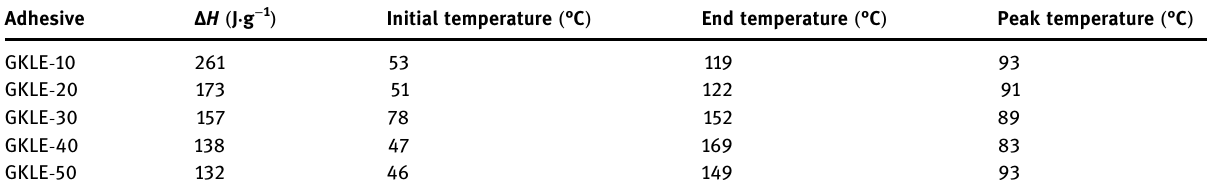
Table 1: Curing parameters of lignin - based adhesives Adhesive